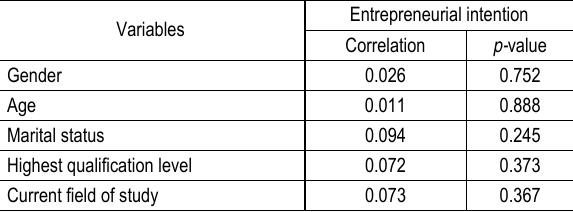
Table 4. Correlation of EI and control variables